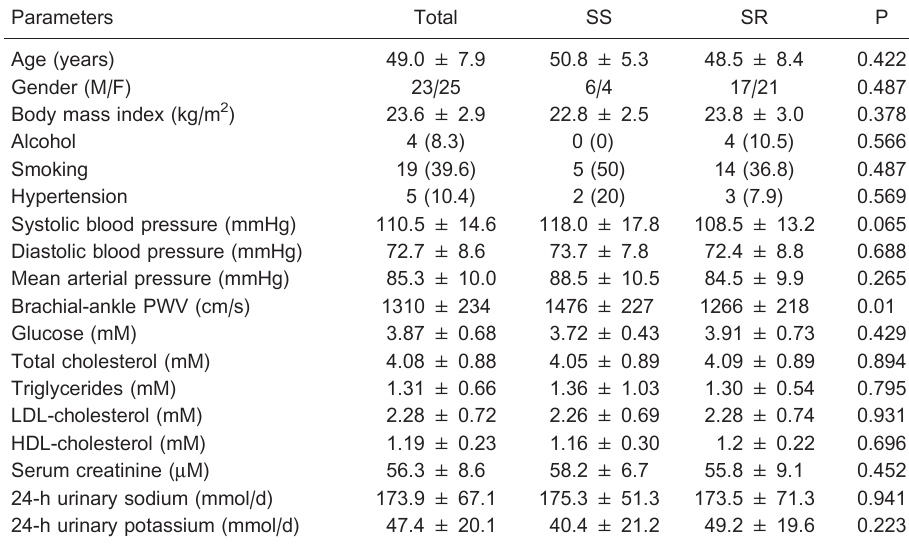
Table 1. Baseline demographic and clinical characteristics.